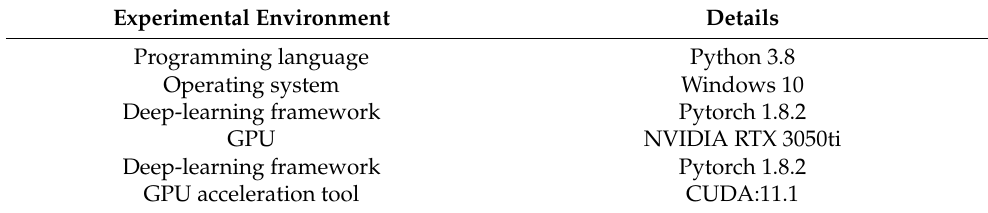
Table 2. Experimental conditions.